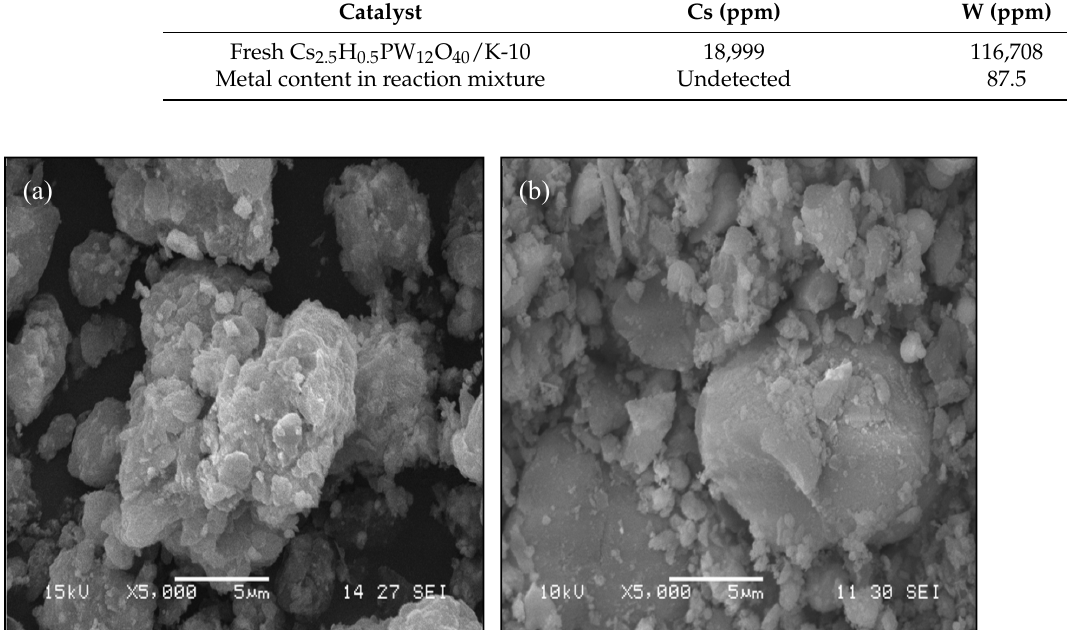
Figure 3. SEM images of ( a ) fresh Cs-DTP/K-10 catalyst and ( b ) used Cs-DTP/K-10.